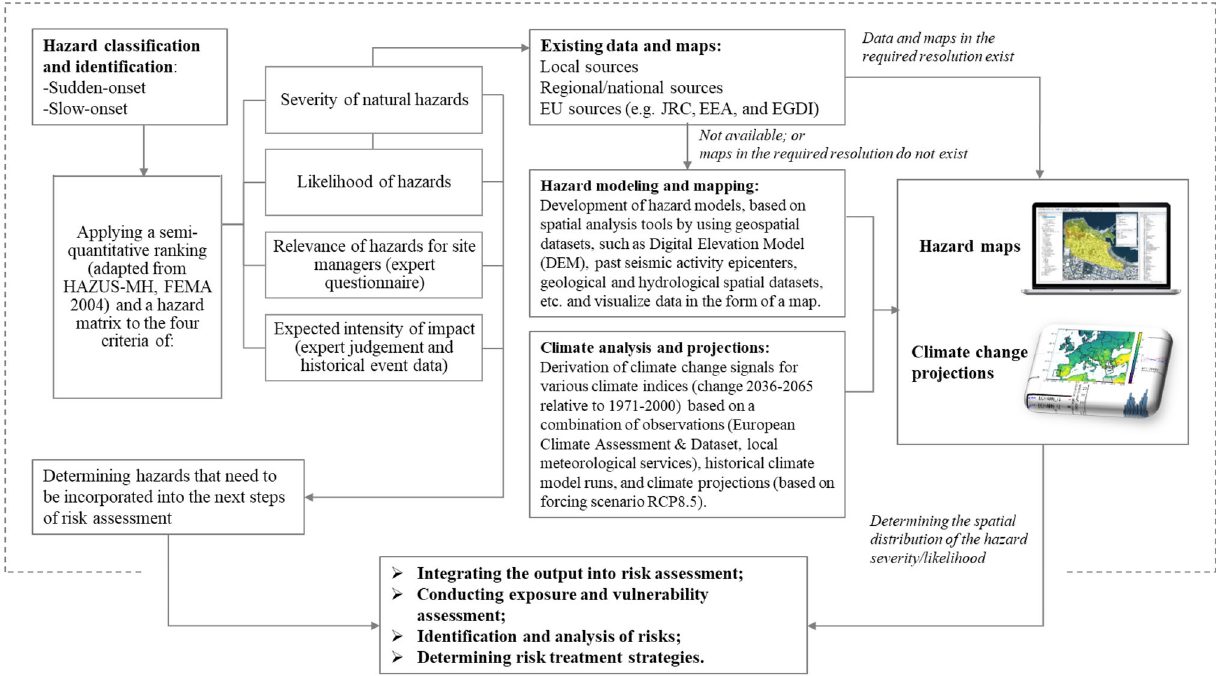
Fig. 2 Assessing natural hazards, including climate change projec- tions, within the risk assessment procedure for the Historic Centre of Rethymno, Crete, Greece EU = European Union; JRC =